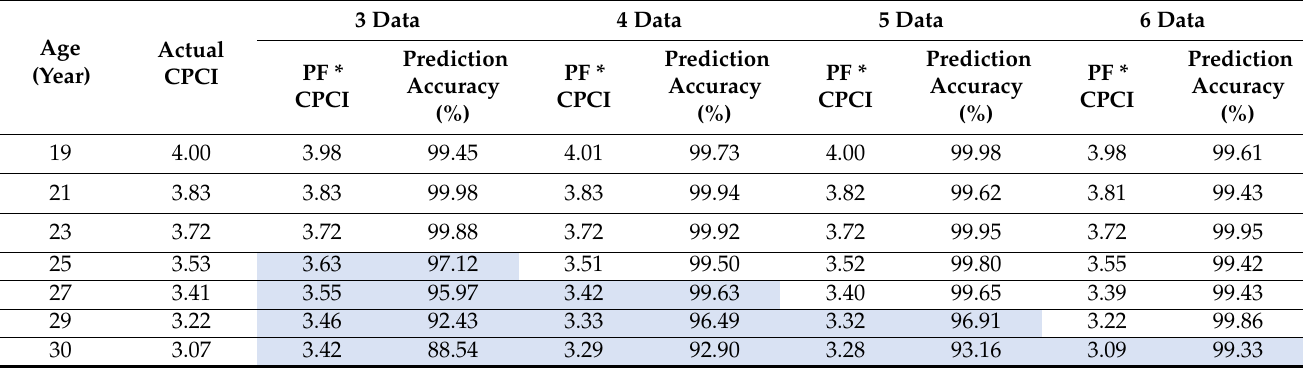
Table 4. Estimation of prediction accuracy according to the change in the number of time-series points in the same